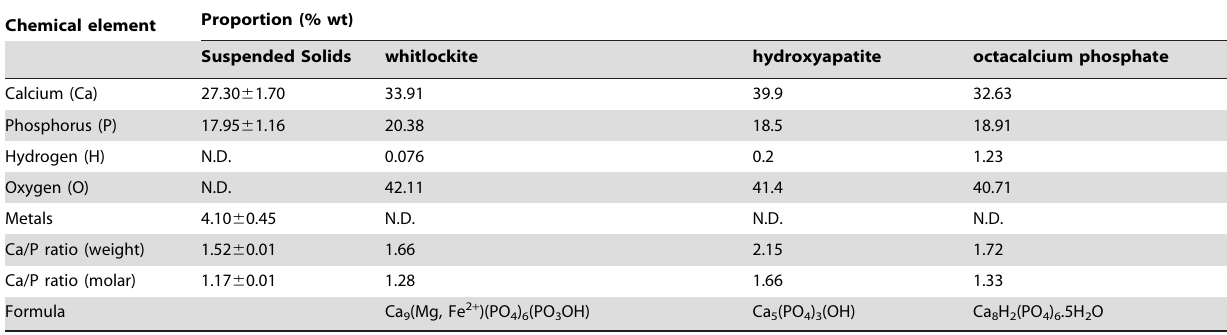
Table 2. Comparison of the elemental chemical composition of whitlockite [27], hydroxyapatite [52], octacalcium [53] to the elemental composition of suspended solids obtained after 39 days of C. hydrogenoformans growth on DSMZ medium. N.D.: not determined.